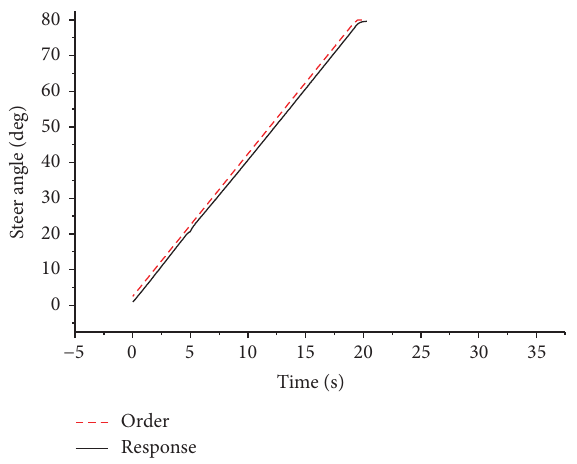
Figure 23: Steer angle.